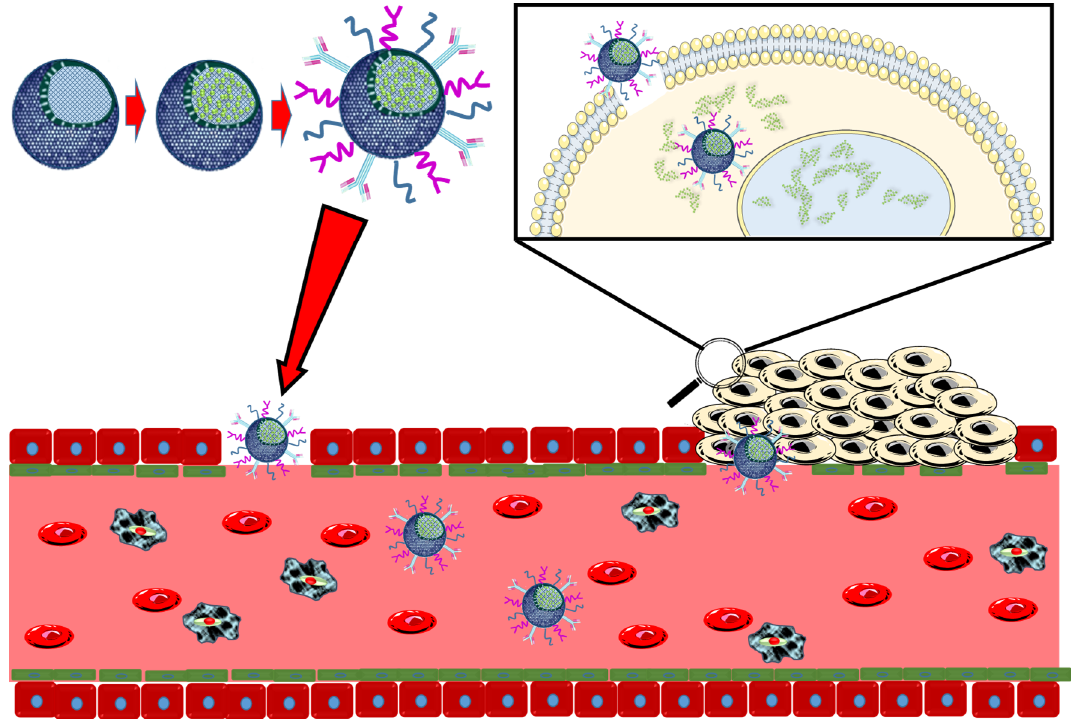
Figure 2. Blood compatibility, colloidal stability, and cell recognition are necessary on therapeutic nanosystems; otherwise, they would not reach their final destination.